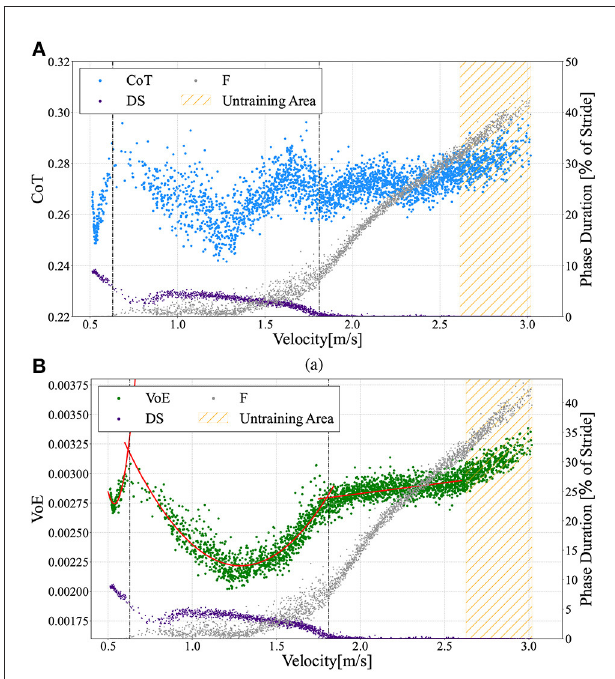
FIGURE8 (A) Cost of Transport (CoT) vs. measured velocities graphs here include data from a 10 to 30 m distance locomotion in the ω v range from 0.0 to 2.93 in 0.01 intervals, similar to Figure 5. (B) Variation of Energy (VoE) vs. measured velocities divided into three patterns: (1) walking 0.51 x transient gait 0.63 1.81m / s, and (3) running gait ≤ ˙ ≤ The vertical dotted lines describe the borders at x 1.81m / s (right). The VoE for walking gait and transient gait can be ˙ = approximated by quadratic curves (red lines) of VoE w x 2 x 0.0694 0.075 0.0229 and ˙ ˙ = − + VoE t x 2 x 0.0022 0.0058 0.0059, respectively. For the running gait ˙ ˙ = − + mode, a straight line represents the function VoE r x 0.00018 ˙ = +